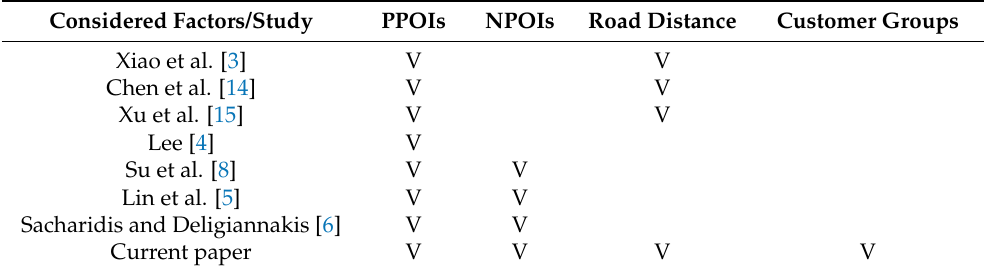
Table 1. Comparison of related